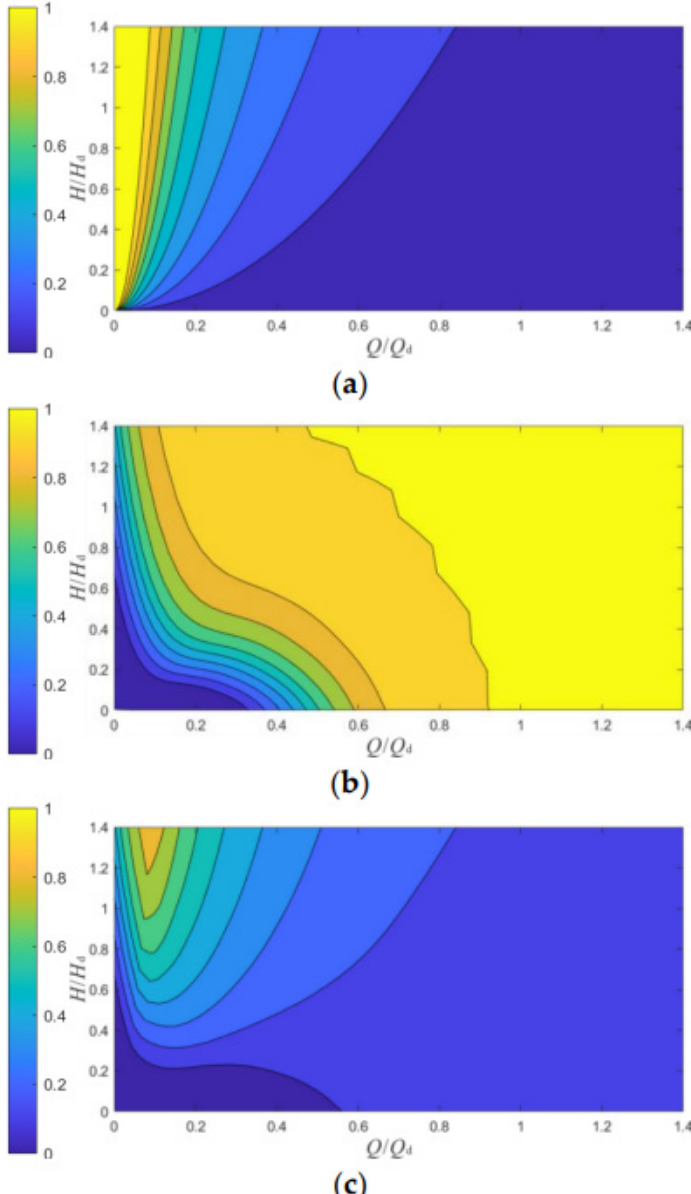
Figure 4. P th , F mr, and P m data analysis diagram corresponding to fish length of 50 mm. ( a ) Impellers impact probability under different working conditions. ( b ) Cutting probability of impeller under different working conditions. ( c ) Fish mortality under different working conditions.